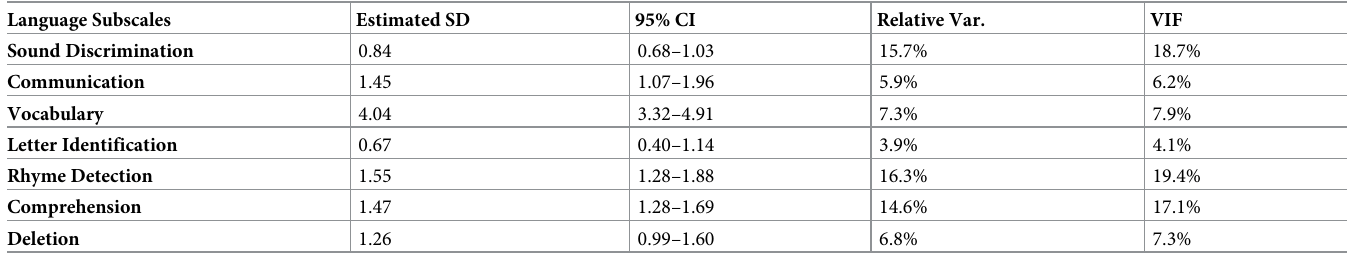
Table 3. Estimated SD, relative variance, and VIF assigned to